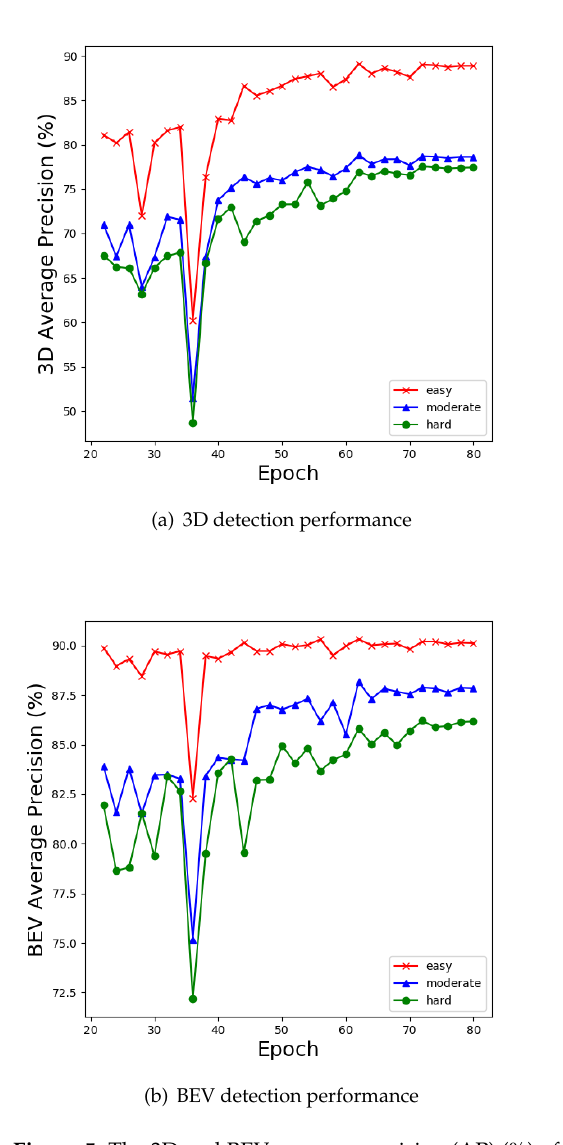
Figure 5. The 3D and BEV average precision (AP) (%) of different epochs on the KITTI validation